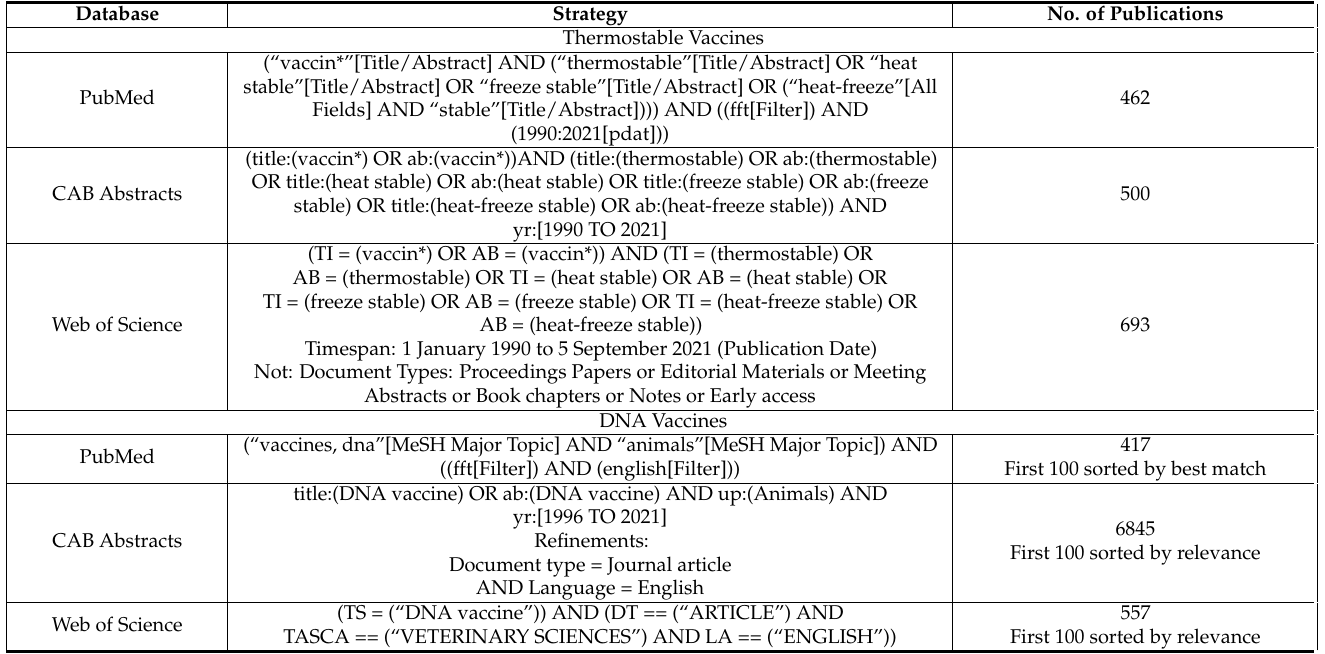
Table 1. Computerized literature search using database-appropriate